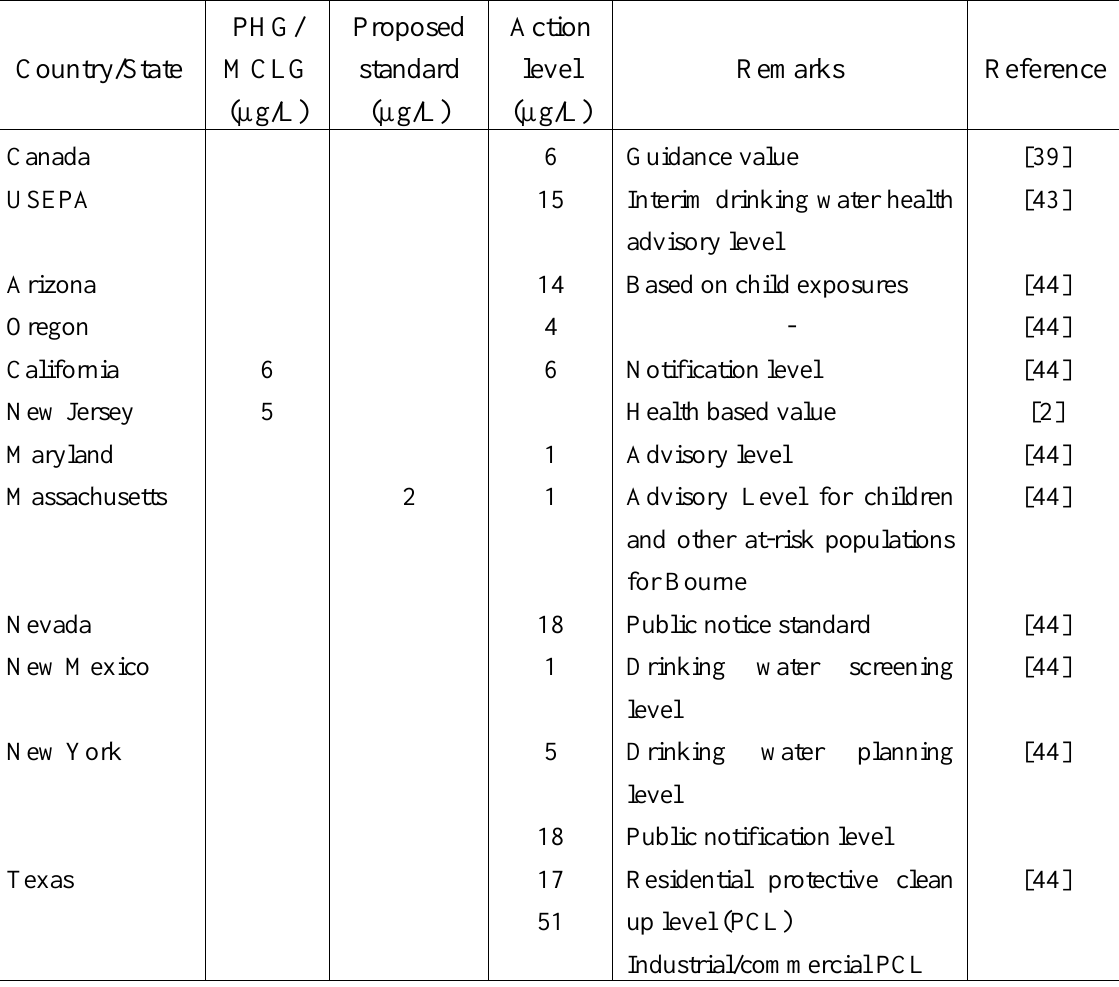
Table 4. Summary of proposed state drinking water standards or action levels for perchlorate as of March